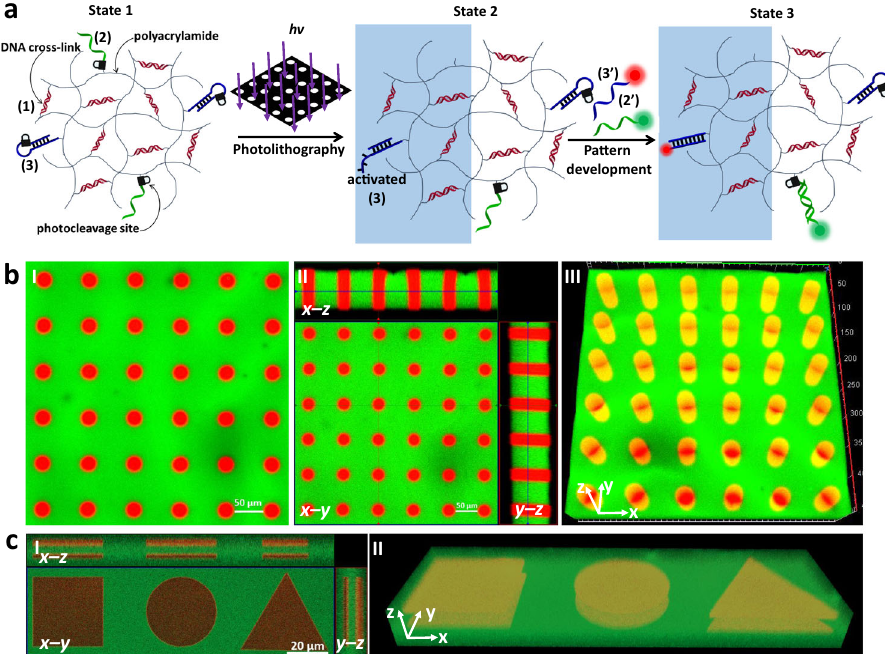
Fig. 4 Light-induced orthogonal patterning of a hydrogel exhibiting dual functionalities. a The polyacrylamide (1)-crosslinked hydrogel is functionalized with the o-nitrobenzylphosphate ester nucleic acids (2) and (3). Exposure of the hydrogel to light yields in the illuminated domains the activated strand (3) and retains in the non-irradiated domains the free nucleic acid strand (2). The dual patterned functionalities allow the selective association of (3 ’ )-TAMRA and (2 ’ )-FAM to the respective domains. b Panel I — Confocal fl uorescence image of the circular periodic pattern of (3 ’ )-TAMRA on the continuous hydrogel functionalized with (2 ’ )-FAM. Panel II — Three-dimensional confocal fl uorescence imaging of the patterned hydrogel according to the process outlined in Fig. 4a. Panel III — Reconstructed three-dimensional fl uorescence image of the hydrogel fi lm generated according to Fig. 4a. Scale bars correspond to 50 μ m. c Panel I — Three-dimensional fl uorescence imaging of two-layered rectangular, circular, and triangle structures patterned by scanning two-photon laser lithography. Panel II — Reconstructed three-dimensional pattern of the two-layered structures generated by the scanning two- photon laser lithography process. Scale bar corresponds to 20 μ m. N = 4 independent experiments were photolithographically patterned hydrogel. Three-dimensional photolithographic patterning of non-crosslinked circular polymer “ hole ” domains in a continuous crosslinked hydrogel matrix. The cylinders in a periodically spatially-separated order, consisting of TAMRA labeled hydrogel within the background, continuous, parent hydrogel fi lm consists of the polyacrylamide matrix fl uorescein labeled hydrogel are observed. Similarly, the photo- crosslinked by the photoprotected o-nitrobenzylphosphate ester lithography process was applied to generate hydrogel fi lm that functionalized duplex (4) to which the photoprotected nucleic includes ordered strip patterns, Supplementary Figure 1. acid tethers (2) and the photoprotected hairpins (3) are linked, Fig. 5a. Photoirradiation of the hydrogel through the circle- containing mask removes from the irradiated hydrogel areas the crosslinking units (4) and the single-strand tethers (2). Con- comitantly, the photoprotected hairpin (3) is cleaved, resulting in the formation of the activated (3), in a form of a duplex consisting of a single-strand nucleic acid toehold. On the other hand, all background hydrogel domains, that were not exposed to the light-induced process, consist of the (4)-crosslinked hydrogel that is further functionalized with the photoprotected hairpin modules (3) and the single-strand photoprotected tethers (2), Fig. 5a. That is the patterned hydrogel fi lm includes circular non- crosslinked polyacrylamide chains functionalized with the toehold-modi fi ed duplexes of the activated (3) units, surrounded by the (4) duplex crosslinked hydrogel modi fi ed with the single- strand tethers (2), and the caged hairpin units (3). Supplementary Figure 2 shows the SEM images of the parent hydrated hydrogel fi lm prior to the photopatterning process, panel I, and the photochemically patterned hydrogel fi lm, panel II. The parent hydrogel fi lm shows a porous structure consistent with a crosslinked hydrogel matrix. The photopatterning process leads to the apparent formation of spatially periodically separated “ holes ” on the background porous hydrogel surrounding. The results are consistent with the formation of non-crosslinked